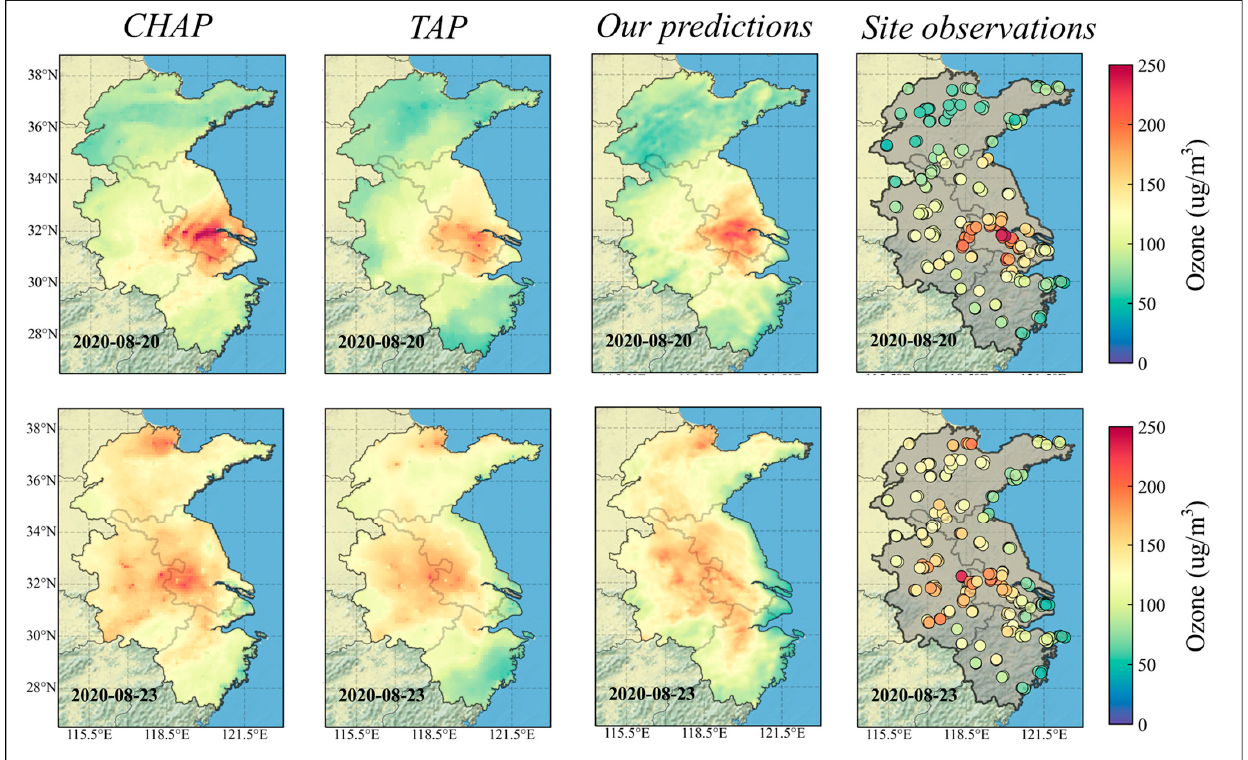
Figure 10. Daily distribution of MDA8 ozone of CHAP, TAP, our predictions, and site observations.